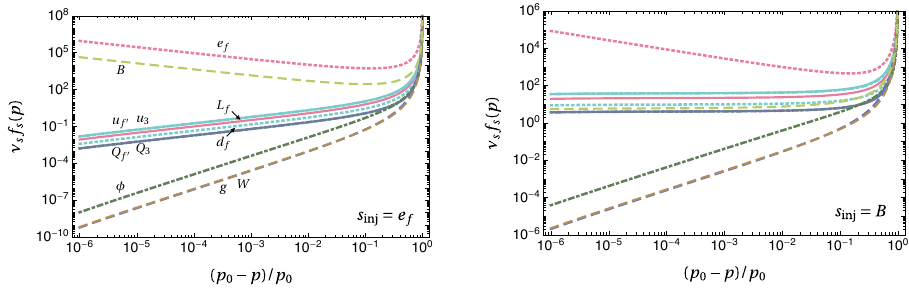
Figure 7 . Particle distributions for p ≈ p 0 . The primary particle is injected solely for e f (left) and B (right). The asymptotic behaviors for p ≈ p 0 are consistent with the analytic result shown in figure